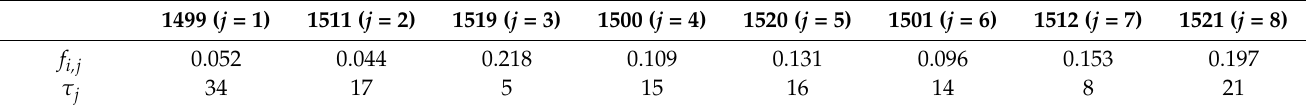
Table 2. The values obtained by combining modified CRM and waterflooding performance equation.